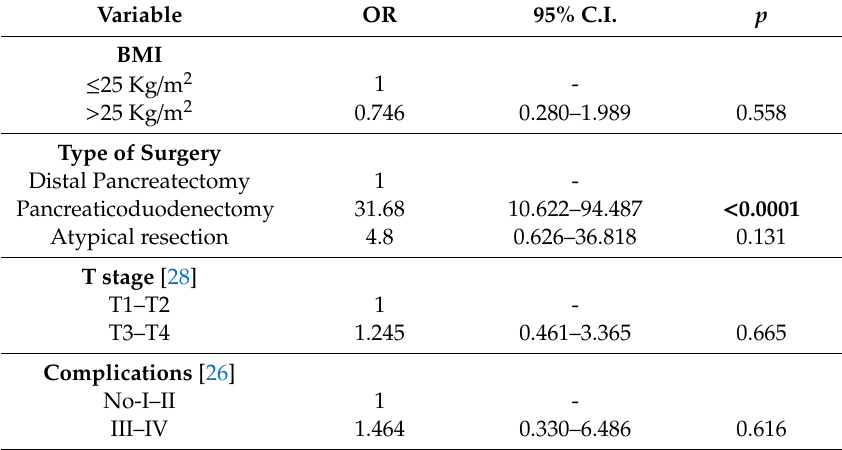
Table 5. Multivariate logistic regression analysis of predictors of postoperative pancreatic exocrine insu ffi